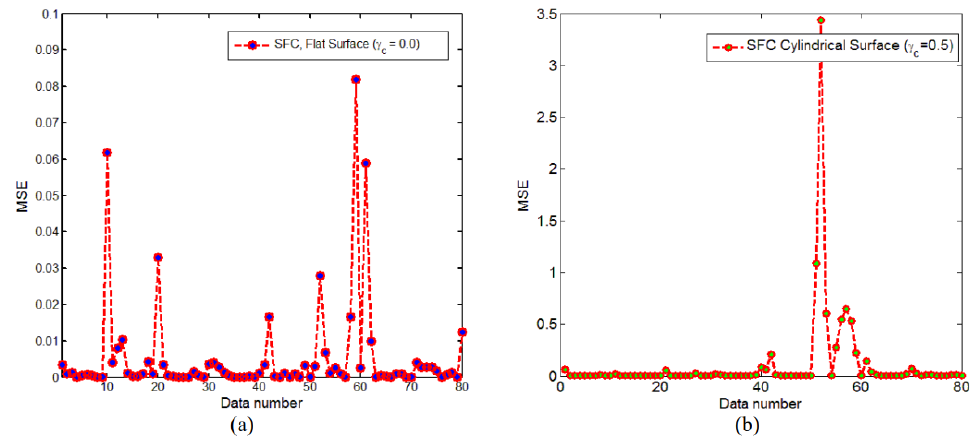
Figure 5. ( a ) MSE for SFC at plat surface; ( b ) MSE for SFC at cylindrical surface. Figure 6a,b o ff er the regression values of SFC data for fl at and cylindrical surfaces,